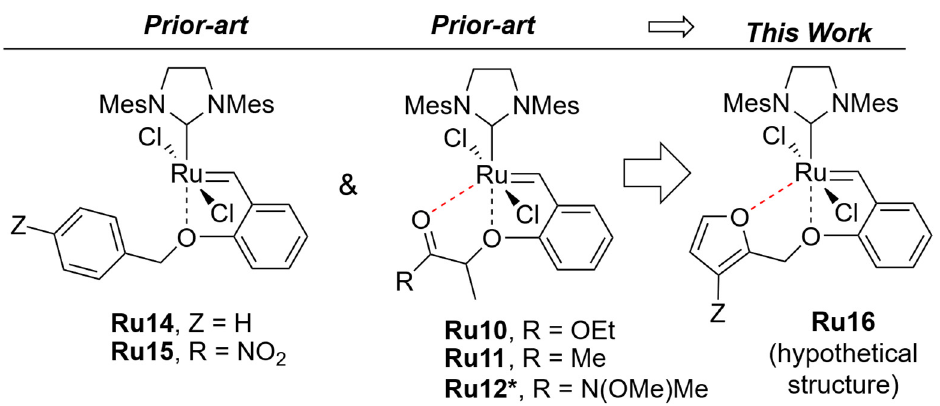
Figure 2. Combined structural characteristics leading to development of a new system. * NHC with Dipp substituent instead of Mes. (For Ru14 and Ru15 , see [48]; for Ru10 and Ru11 , see [33–35]; for Ru12 , see [38]).